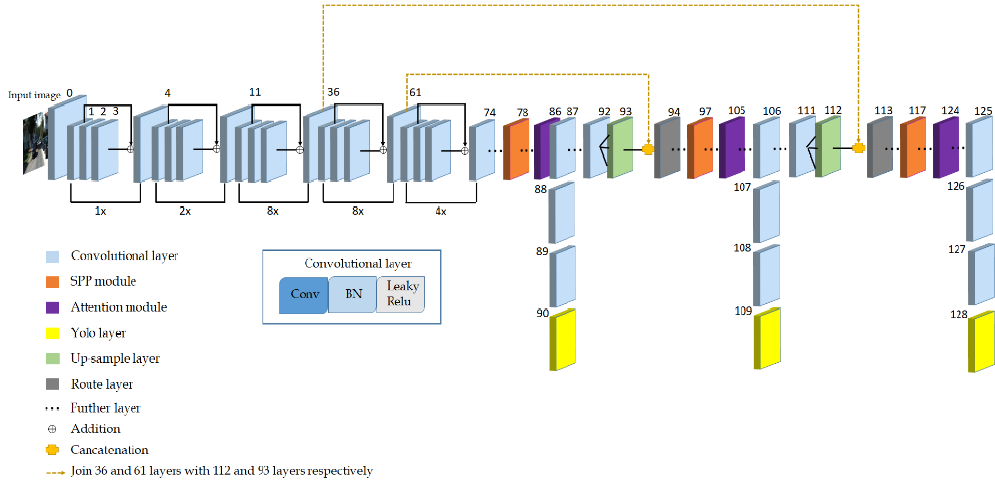
Figure 9. Overall network structure.